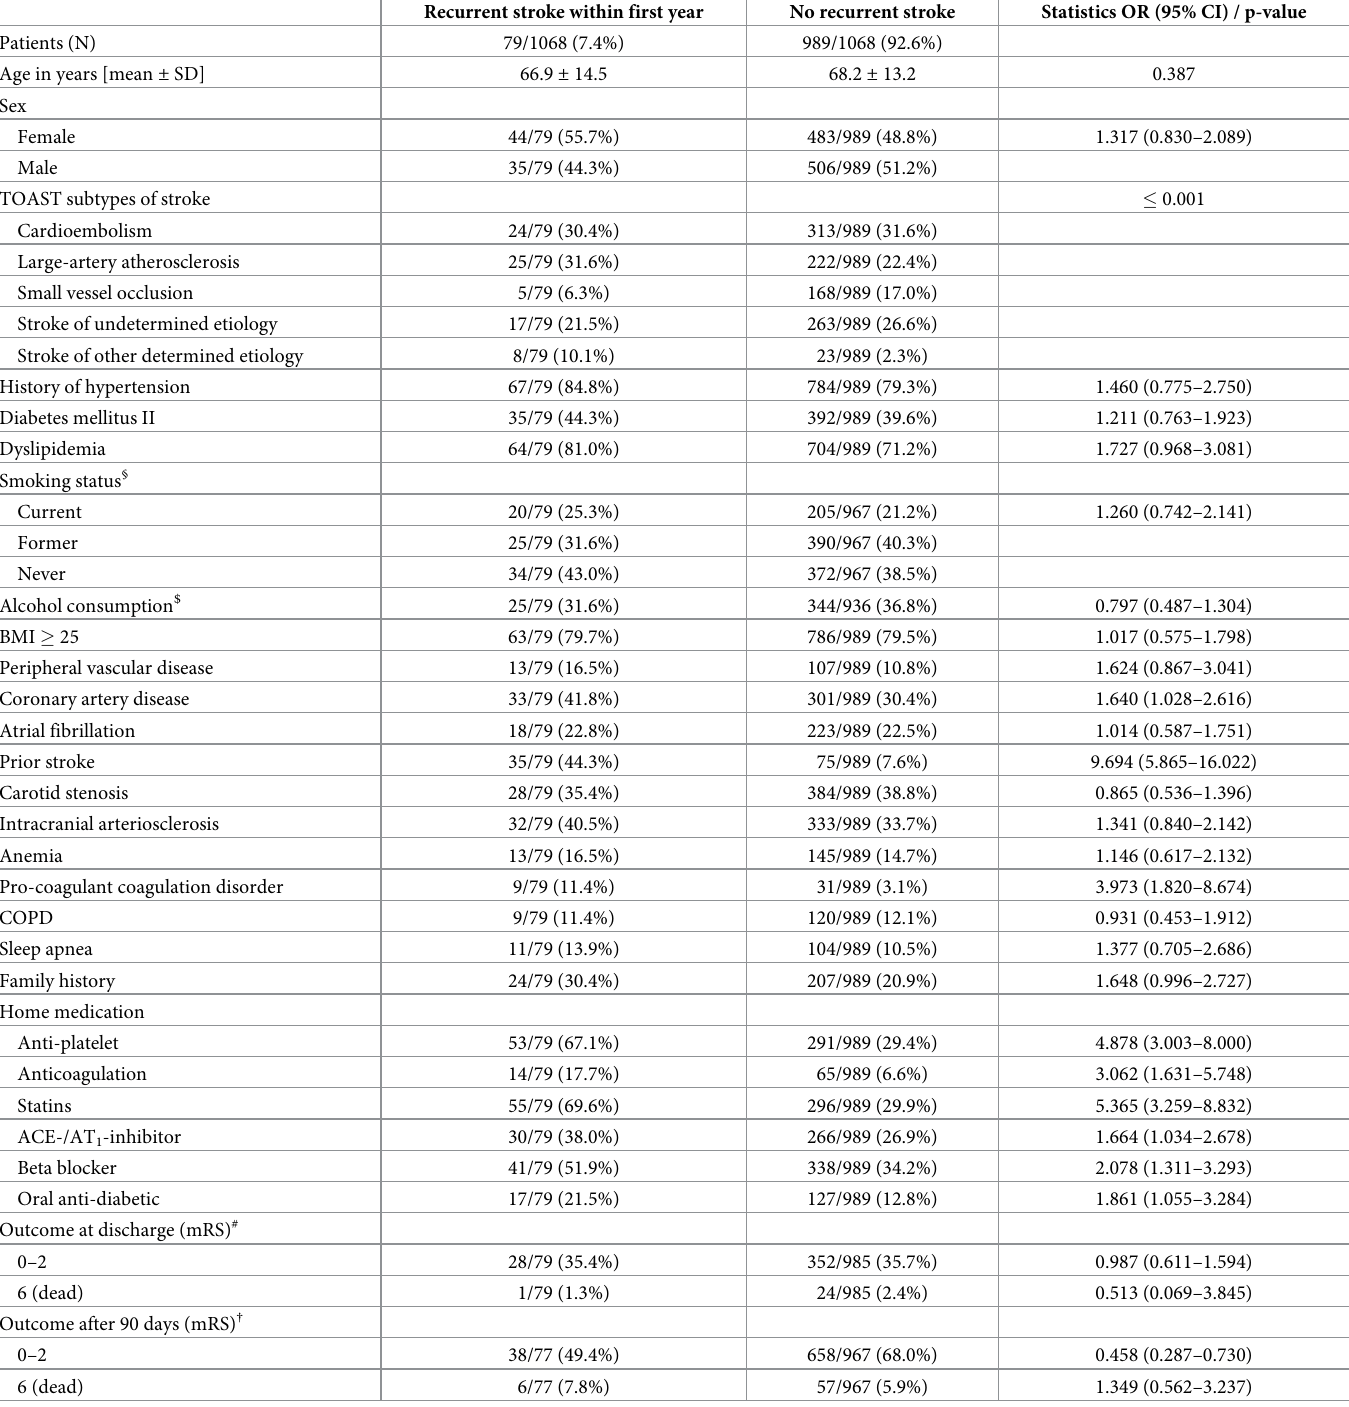
Table 1. Patient